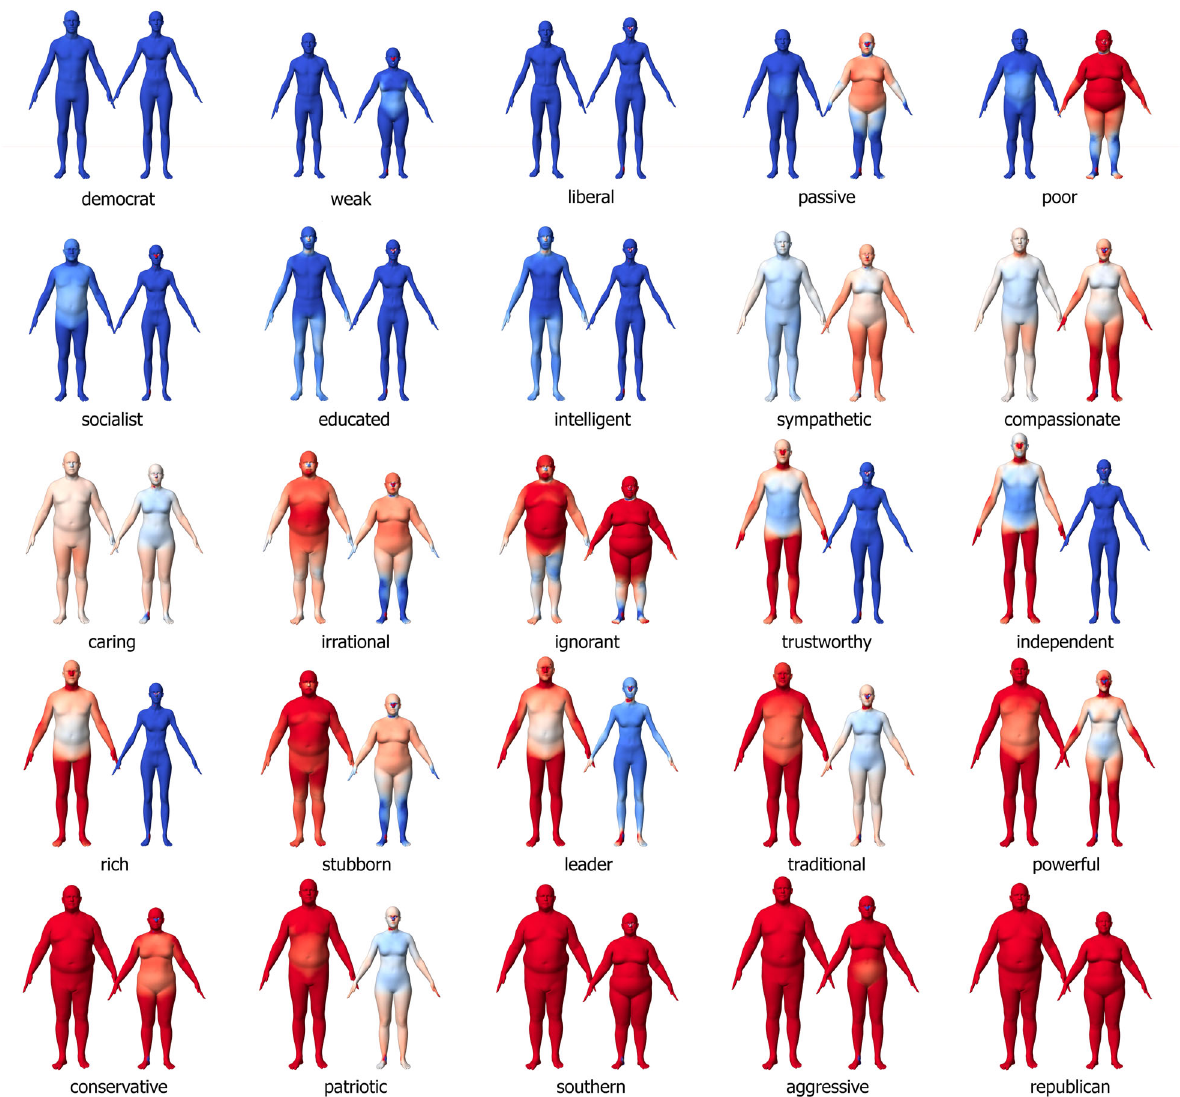
Fig. 2 Visualization of stereotype bodies. Each body pair illustrates the mental representation associated with different political traits for male and female bodies. Blue color indicates a geometric closeness to the Democrat stereotype, while red color represents geometric closeness to the Republican